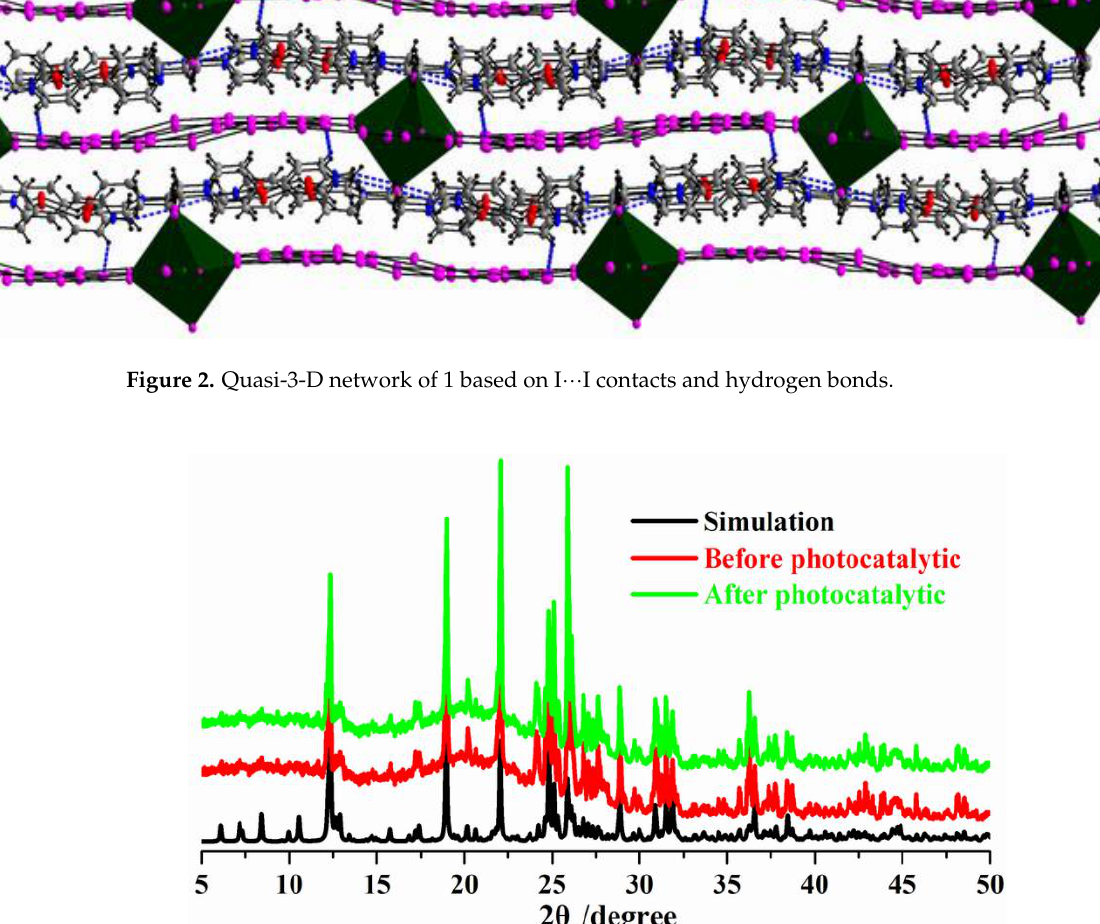
Table 2. Hydrogen Bond Lengths (Å ) and Bond Angles (°). Figure 3. Powder X-ray diffraction (PXRD) patterns under different conditions for 1.